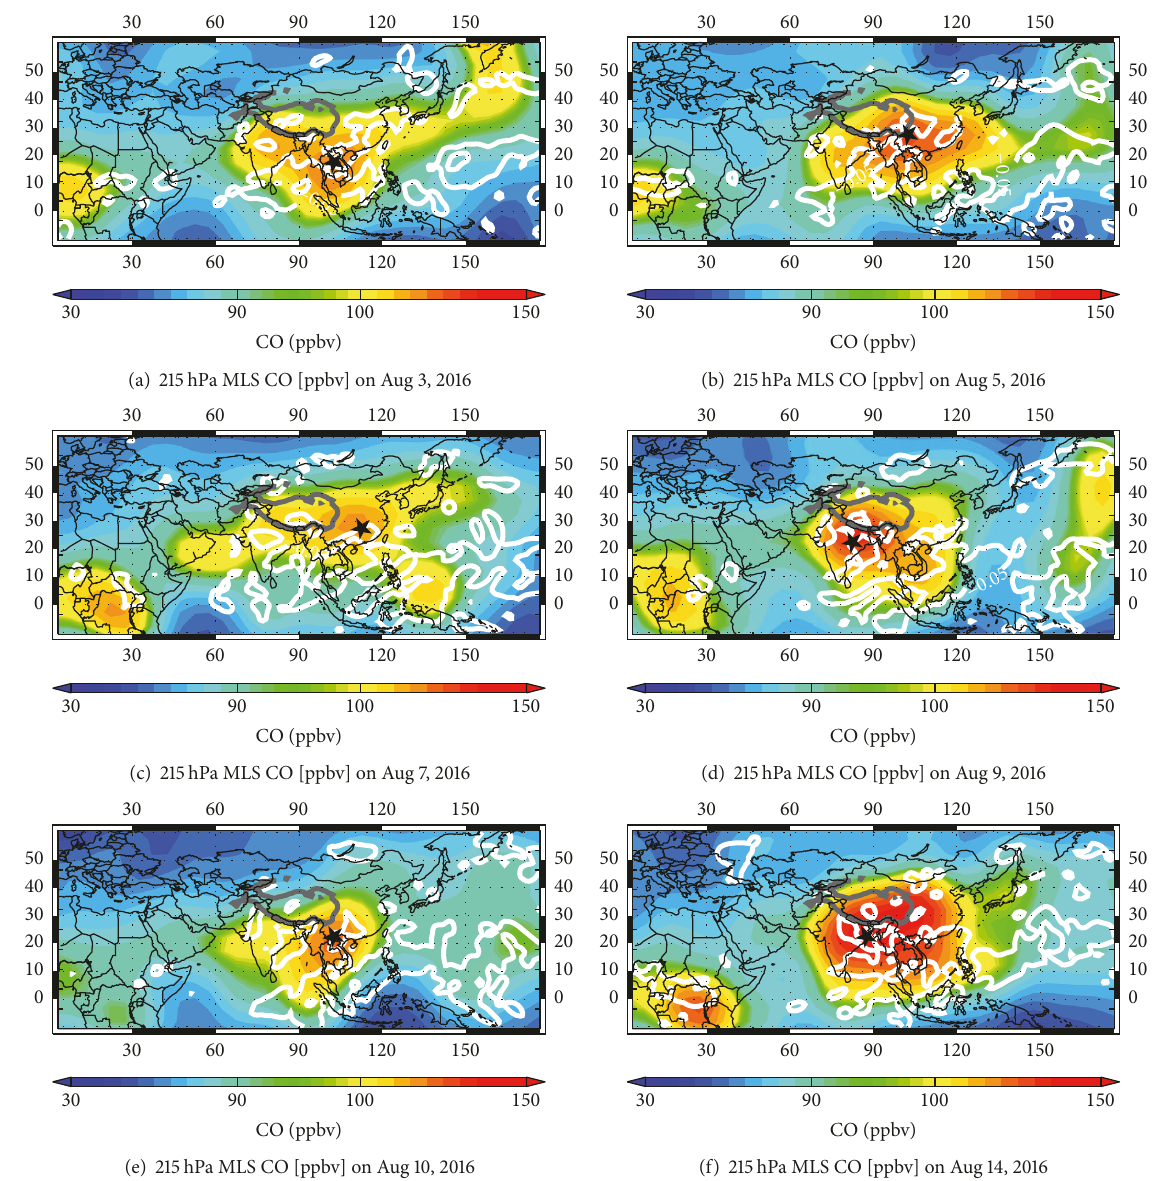
Figure 4: The same as Figure 3, but for MLS CO at 215 hPa and vertical velocity at 200 hPa. The vertical velocity contours are − 5Pa/s.